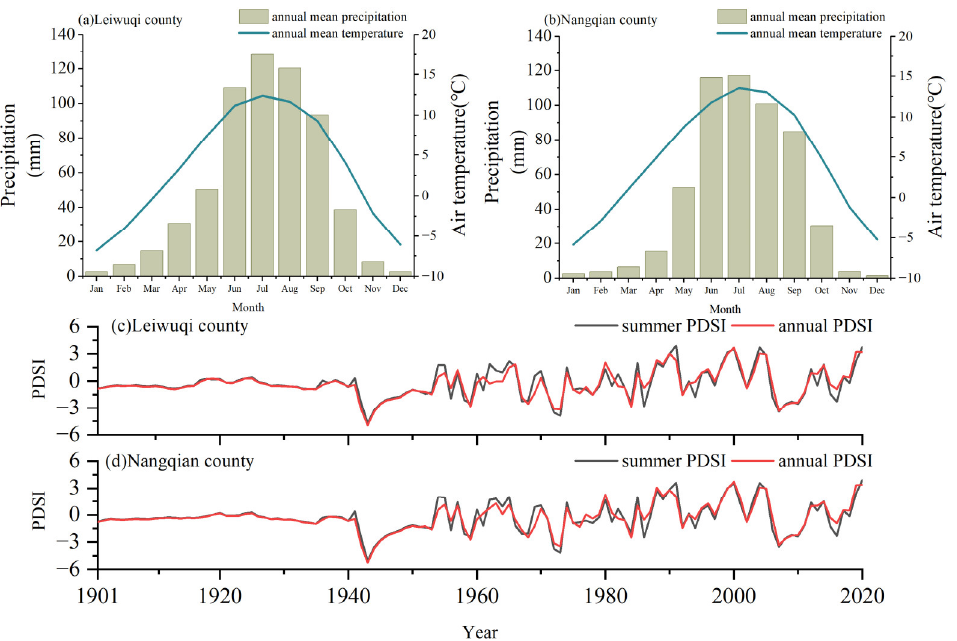
Figure 2. Variations of mean monthly precipitation, mean monthly temperature ( a , b ), average summer, and annual PDSI ( c , d ) in the study area on the eastern TP based on data from meteorological stations and the CRU TS gridded